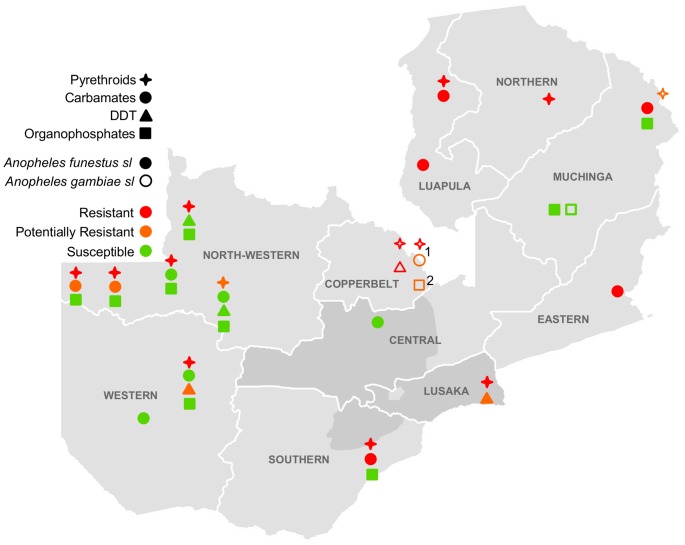
Insecticide resistance in collections from May 2012–April 2013.Darker gray shading indicates areas surveyed in [16]. 1Potentially resistant to bendiocarb but susceptible to propoxur. 2Potentially resistant to pirimiphos-methyl but susceptible to malathion.